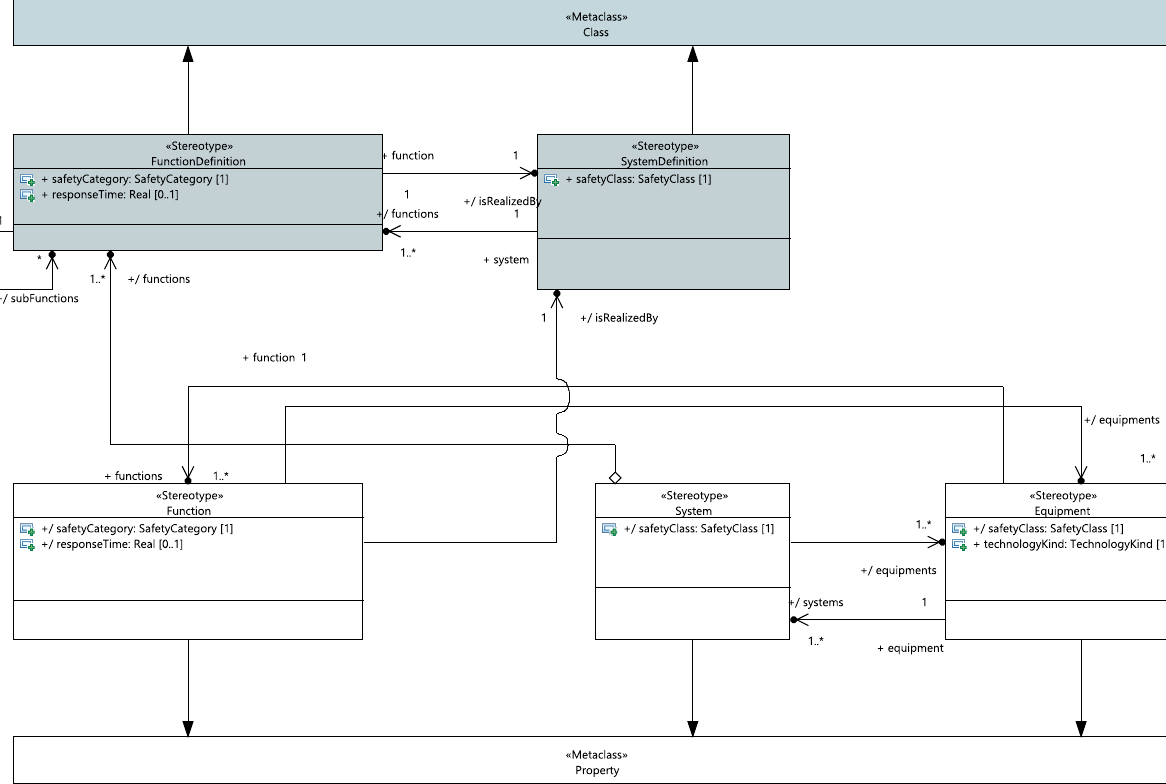
Figure 7. Meta-model of functions and